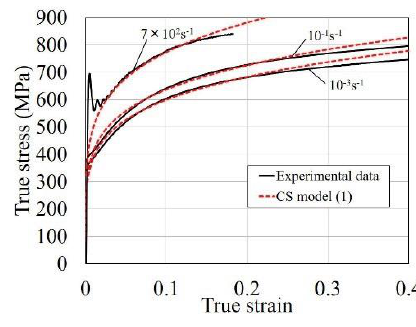
Fig. 4. Comparison between experimental results and CS model of condition (1) in stress- strain relations of SM490B.